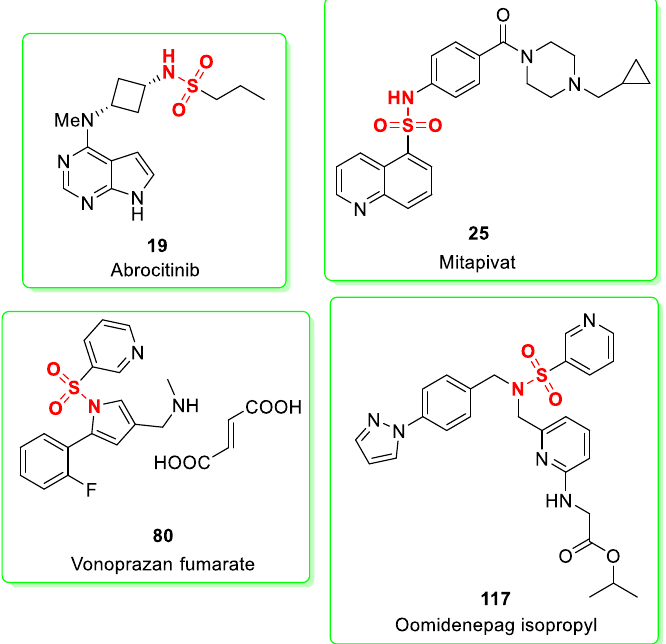
Figure 2. Chemical structure of approved sulfonamides in 2022. Abrocitinib ( 19 ), mitapivat ( 25 ), vonoprazan fumarate ( 80 ) and oomidenepag isopropyl ( 117 ). The sulfonamide moieties are shown in red.